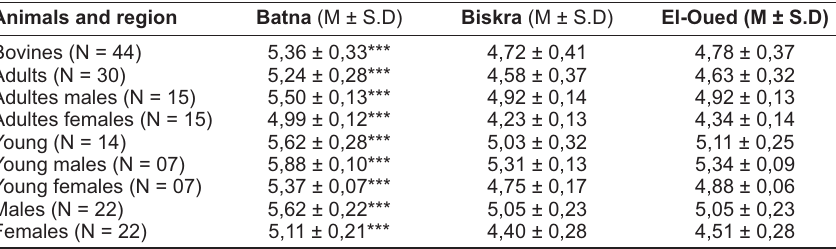
Table-3. Influence of altitude on bovine red blood size (expressed in µm) Animals and